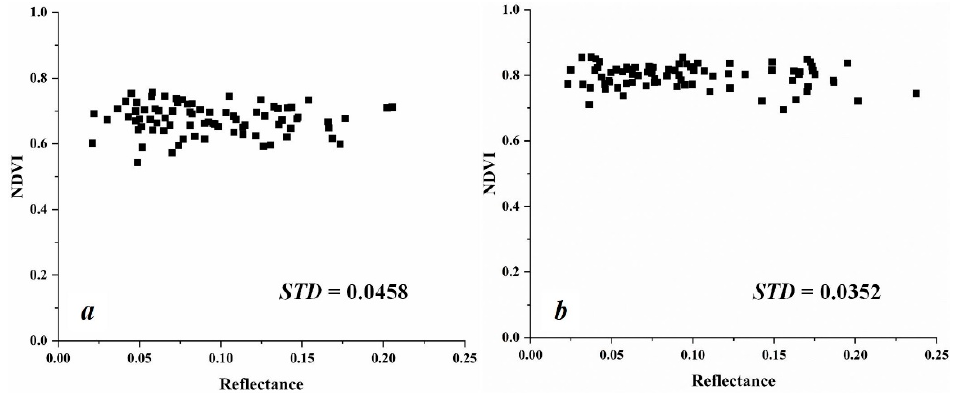
Figure 5. Scatterplot of RE’s reflectance and the NDVI for Pinus ( a ) and Larix ( b ).